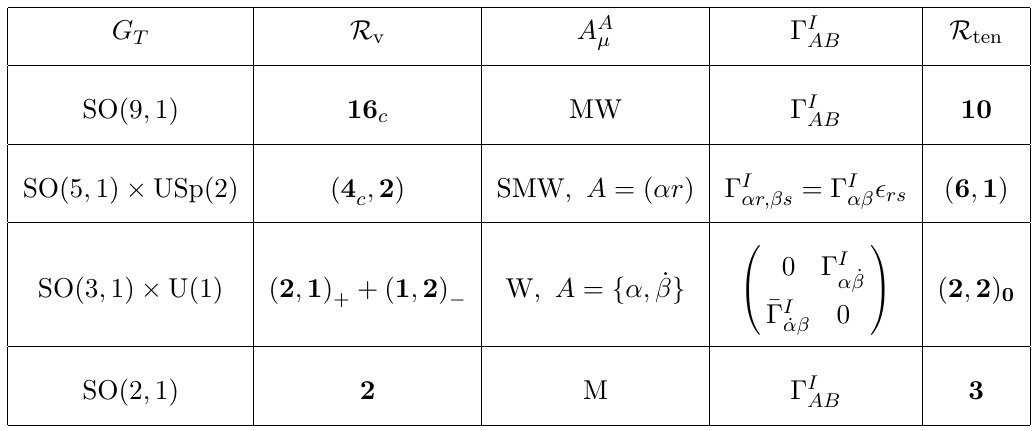
Table 2 . Above we reproduce the field content and symmetries of magical supergravity theories in six dimensions. The first column lists their global symmetry groups G T and the second column lists the representations R v of the vector fields A A under G T . The reality properties of these µ representations are given in the third column: Majorana (M), Weyl (W), Majorana-Weyl (MW), symplectic Majorana-Weyl (SMW). The last column lists the representations R ten of the tensor fields under G T . Γ I are the gamma matrices in the respective